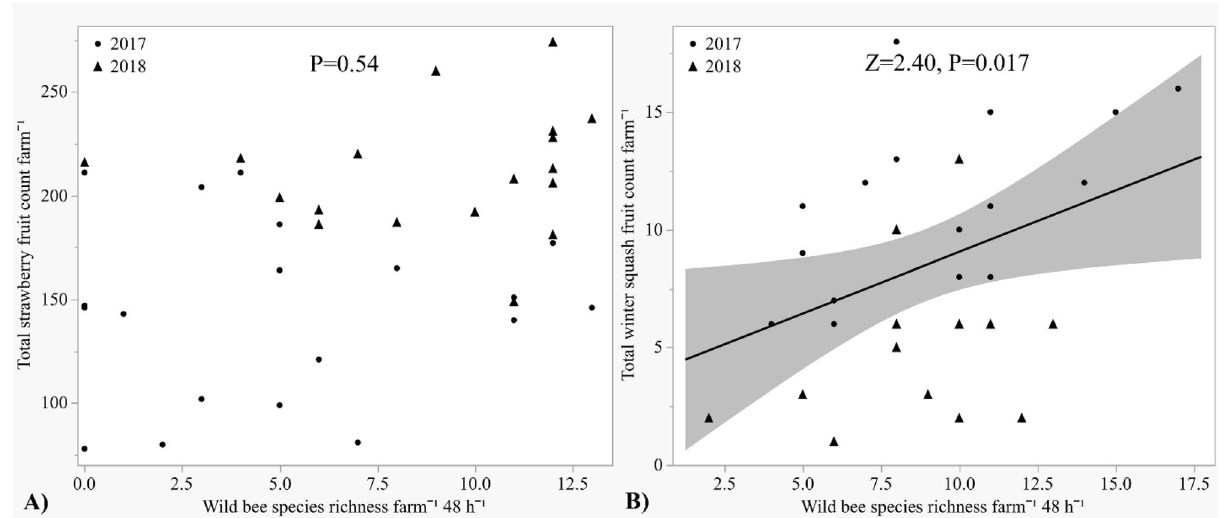
Figure 5. Total strawberry and winter squash fruit count analyzed by wild bee species richness: ▲ = 2017, = 2018. ( A ) Strawberry fruit count, ( B ) Winter squash fruit ●